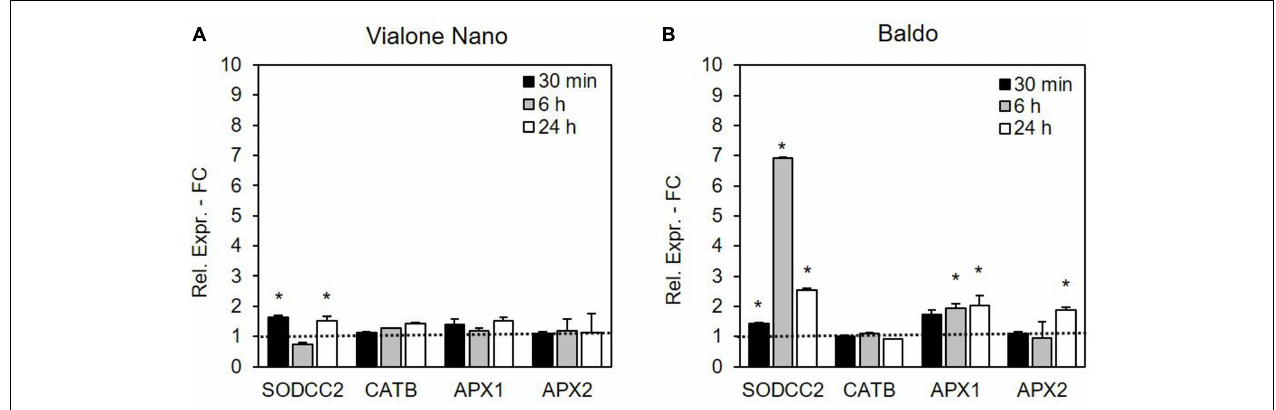
FIGURE 9 | Relative expression (fold change) of the SODCC2, CATB, APX1, APX2, and GSTU6 genes at different times after treatment with 100 mM NaCl in (A) VN and (B) B. Values represent the mean ± SE of three independent experiments at least in duplicate. The asterisk indicates values that are significantly different from those of untreated cells according to Wilcoxon–Mann–Whitney’s test ( p < 0.01).